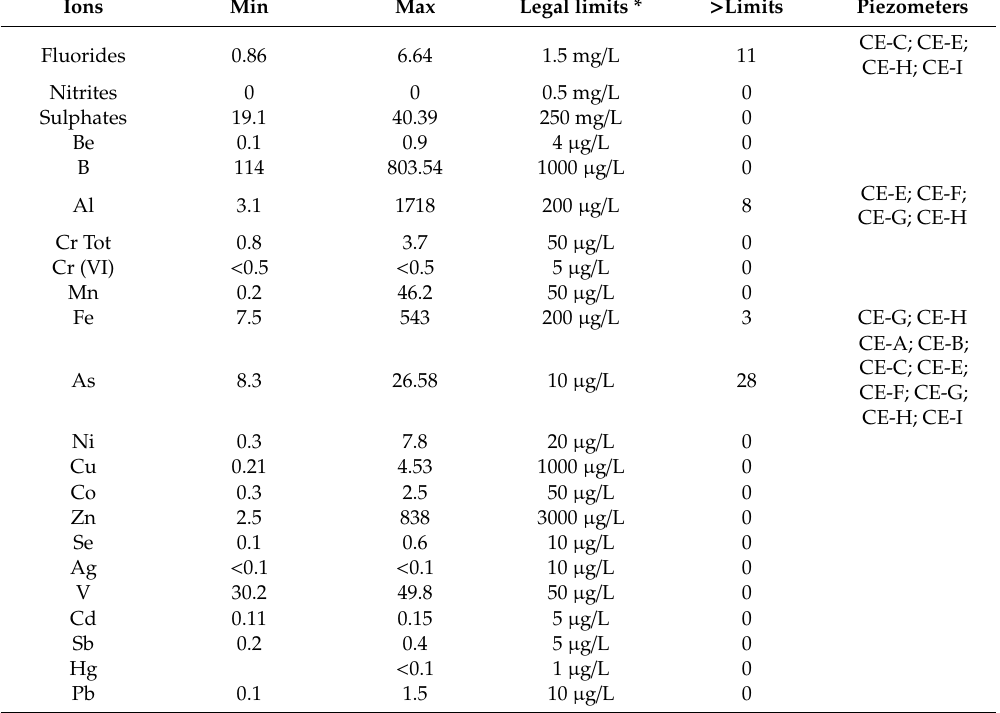
Table 4. Minimum (Min) and maximum (Max) concentrations of anions and cations found in the four sampling campaigns (second and third column); threshold limits reported in the Italian legislations (fourth column); Numbers of exceeding values and corresponding piezometers (fifth and sixth column).